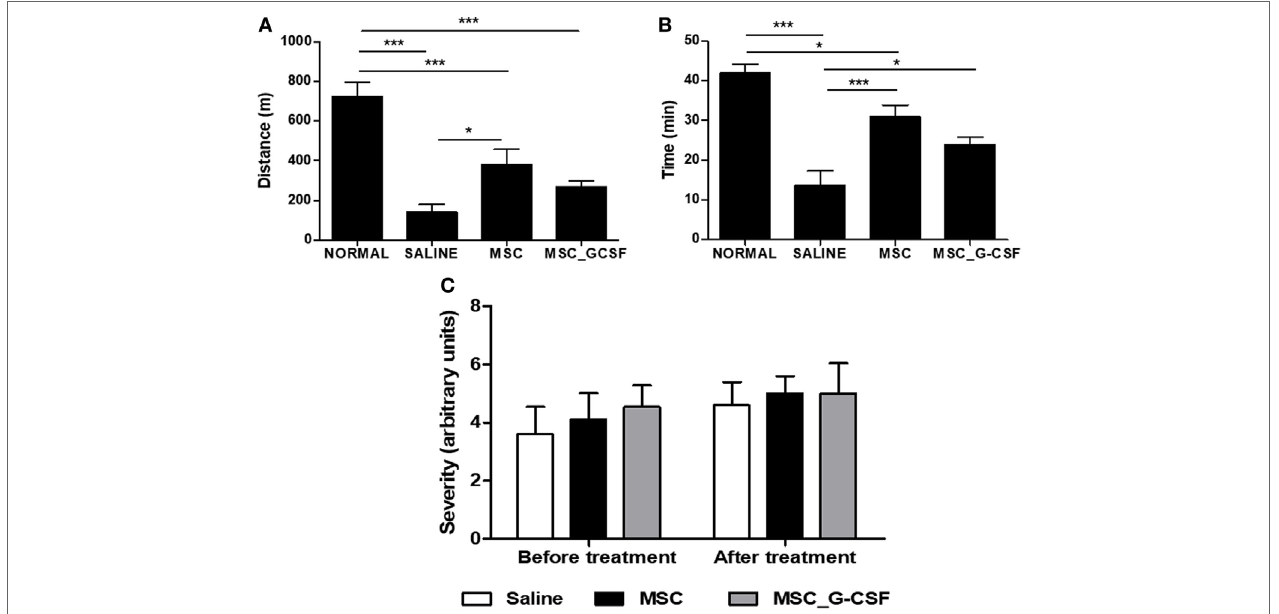
FigUre 4 | Functional analyses of mice treated with mesenchymal stem cells (MSCs) or MSC_G-CSF. Naïve and Trypanosoma cruzi -infected mice (6 months of infection) were evaluated by exercise capacity and electrocardiogram before and 60 days after the beginning of treatment with MSCs, MSC_G-CSF, or saline. Distance (a) and time (B) of exercise evaluated in a treadmill test. Values represent the mean ± SEM of 7–9 mice/group. (c) Conduction disturbances evaluated by electrocardiography. Severity was scored as follows: 0, no cardiac conduction disturbances; 1, first-degree atrium-ventricular block; 2, intraatrium conduction disturbance; 3, junctional rhythm; 4, intraventricular conduction disturbance; 5, ventricular bigeminism; 6, polymorphic ventricular tachycardia; and 7, AV dissociation. Values represent the mean ± SEM of 9–10 mice/group. * P < 0.05; *** P <